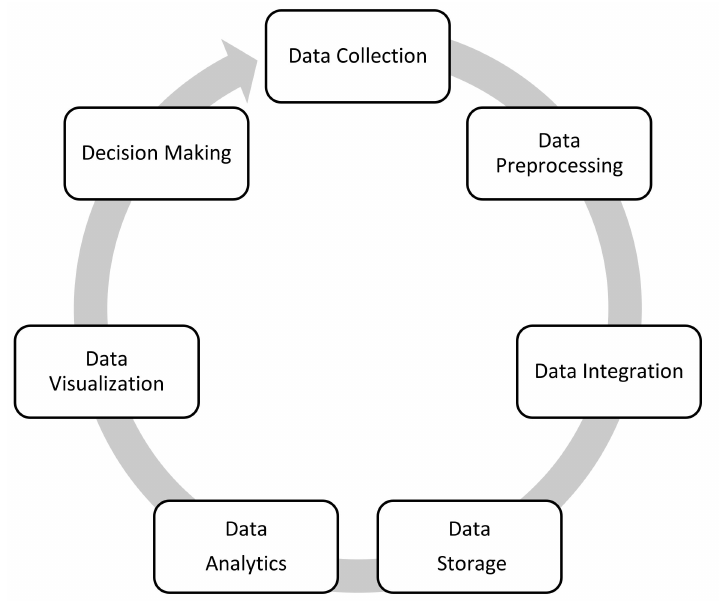
Figure 4. Flow of data in smart